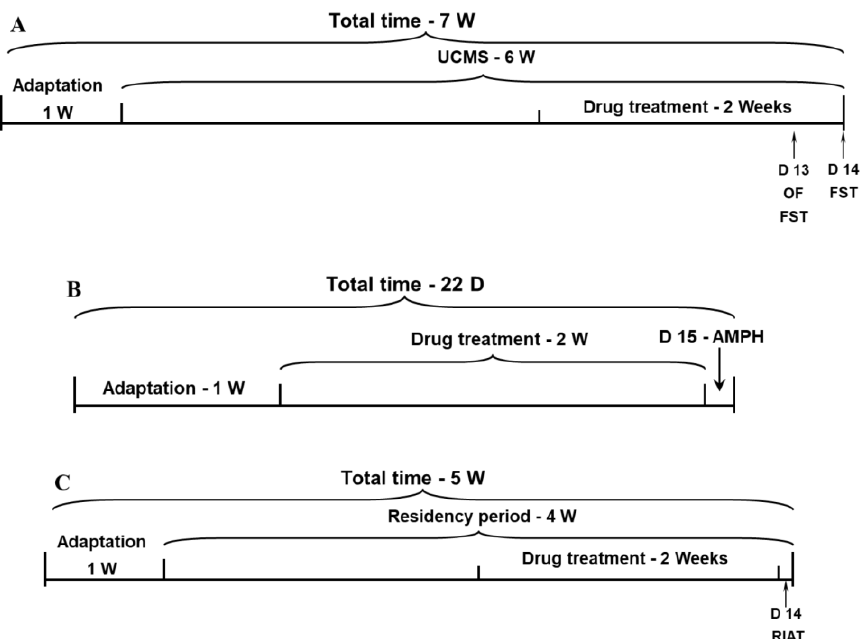
Figure 7. Timeline for the behavioral experiments. ( A ) Timeline of the protocol for the assessment of depressive-like behavior. ( B ) Timeline of the protocol for the assessment of mania-like behaviors. ( C ) Timeline of the protocol for the assessment of aggressive-like behavior. Abbreviations: AMPH, amphetamine; D, day; FST, forced swim test; OF, open field; RIAT, resident-intruder aggression test; UCMS, unpredictable chronic mild stress; W, week.